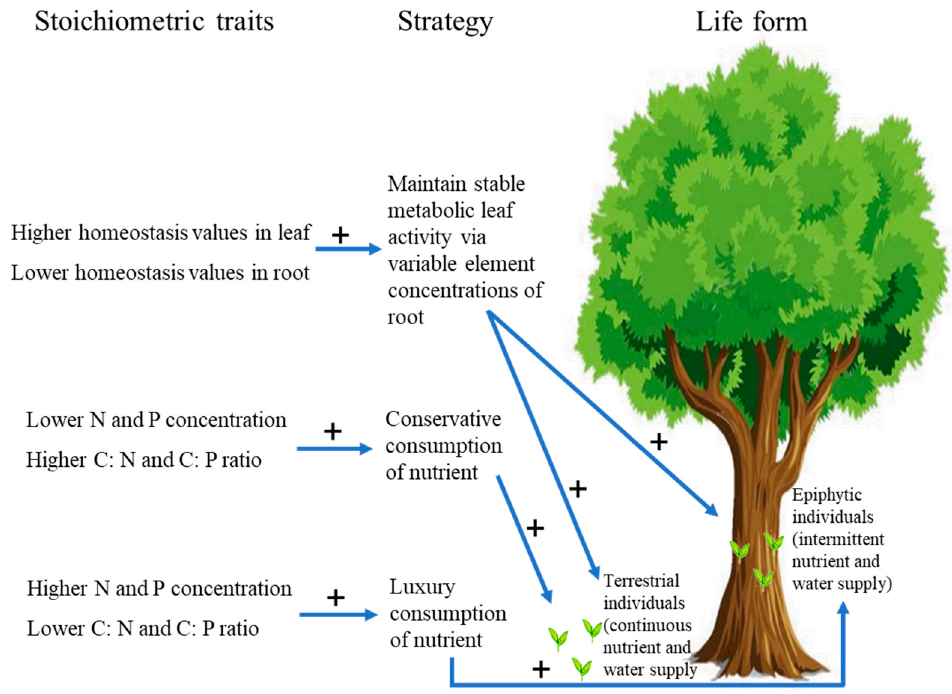
Figure 5. Summary of links between nutrient composition and nutrient use strategy of epiphytic and terrestrial individuals of facultative epiphytes. The ( + ) denotes that effects are positive. Supplementary Materials: Supplementary materials can be found at https://www.mdpi.com/1999-4907/12/1/16/s1. Figure S1: The mean stoichiometric homeostasis ( H ) values for N, and P elements and their element ratios in leaf, stem, and root of different species. Table S1: The difference of stoichiometric traits of C, N, and P concentrations and their element ratios in different organs of